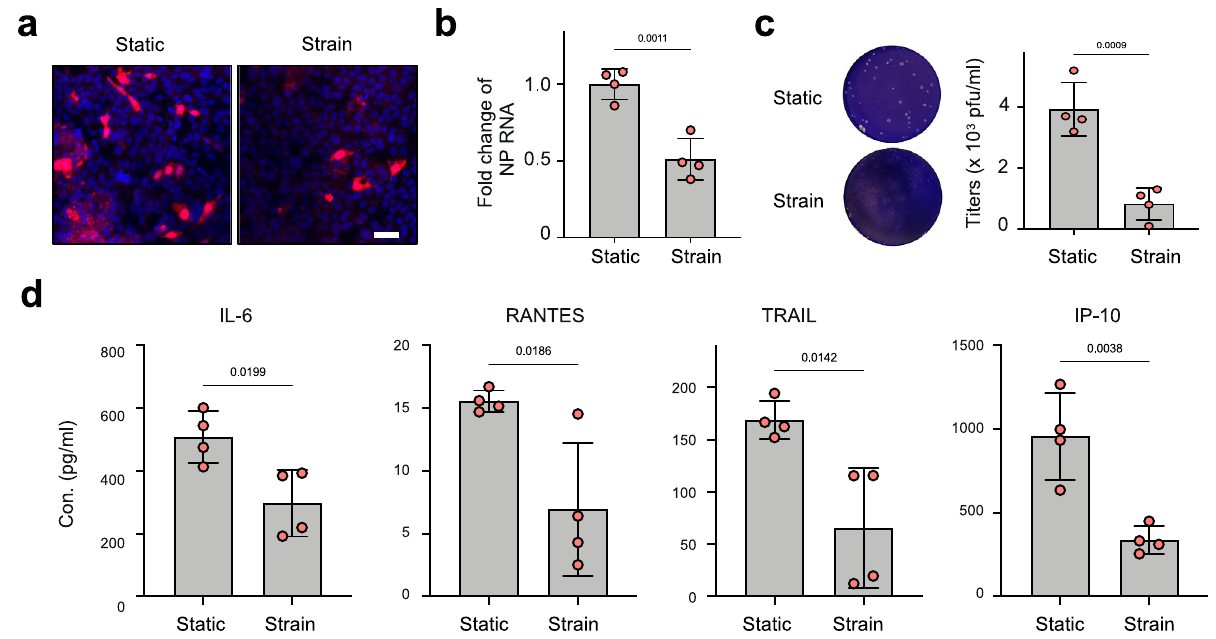
Fig. 4 Cyclic mechanical strain inhibits viral infection in alveolus chip. a Immunostaining of in fl uenza virus NP (red) in alveolus chips that are cultured under static conditions (Static) or under 5% and 0.25 Hz cyclic mechanical strains (Strain) for 48 h and then infected with HK/68 (H3N2) (MOI = 1) for another 48 h (blue, DAPI-stained nuclei; scale bar, 50 µ m). b Graph showing fold changes in RNA levels of in fl uenza virus NP in the epithelium within alveolus chips from a as measured by qPCR. Data represent mean ± SD; n = 4 biological chip replicates; unpaired two-tailed t -test. c Images (left) and graph (right) showing plaque titers of virus in the apical washes of alveolus chips from a . Data represent mean ± SD; n = 4 biological chip replicates; unpaired two-tailed t -test. d Graphs showing cytokine production in the vascular ef fl uents of alveolus chips from a at 48 hpi. Data represent mean ± SD; n = 4 biological chip replicates; unpaired two-tailed t -test. Source data are provided as a Source Data fi